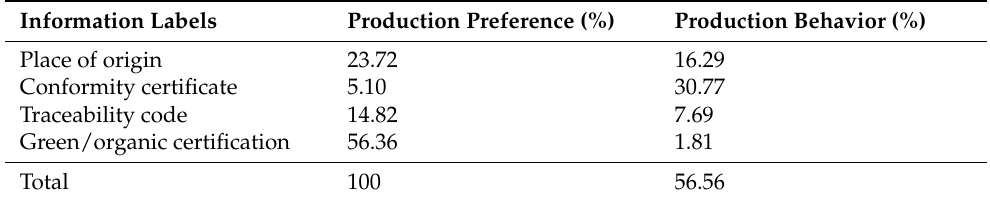
Table 5. Comparison of farmers’ production preferences and behaviors for different information